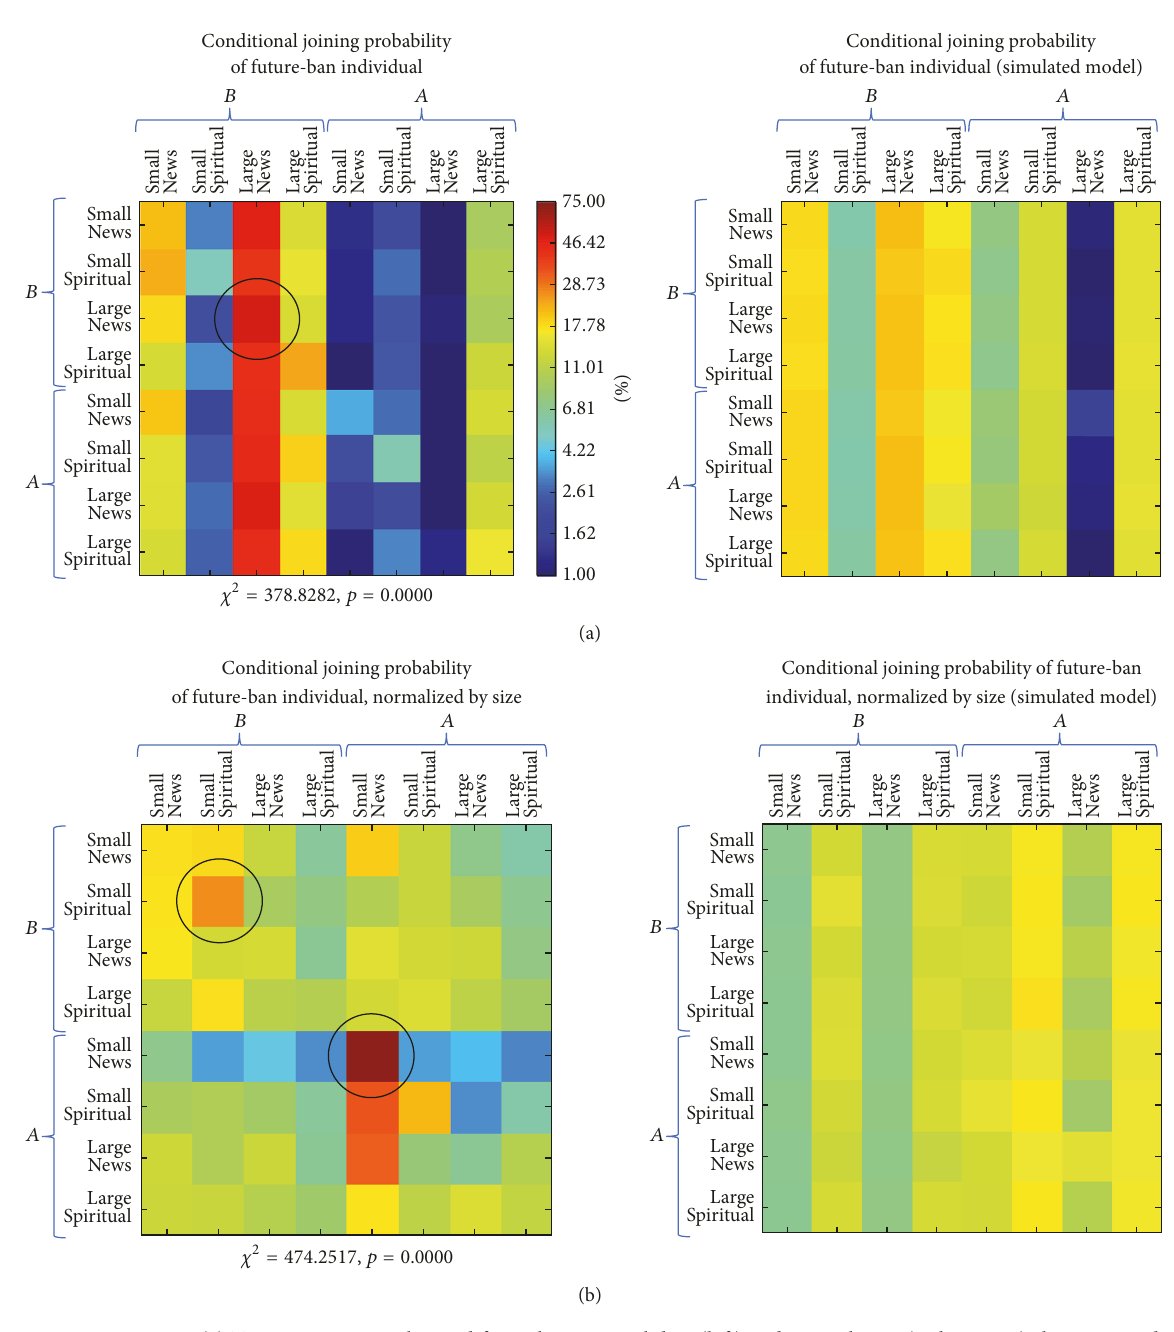
Figure 3: Group-joining . (a) Transition matrix obtained from the empirical data (left) and a simulation (right, see SI) showing conditional probability that a future-ban individual in a group of class 𝑖 (row) will next join a group of class 𝑗 (column). Future-ban individuals have the greatest preference for next joining a banned, large, news group, with this type of group acting as a global attractor (black ring). (b) Corresponding result after renormalizing by the number and size of groups in class 𝑗 . Two additional weaker attractors now emerge (black